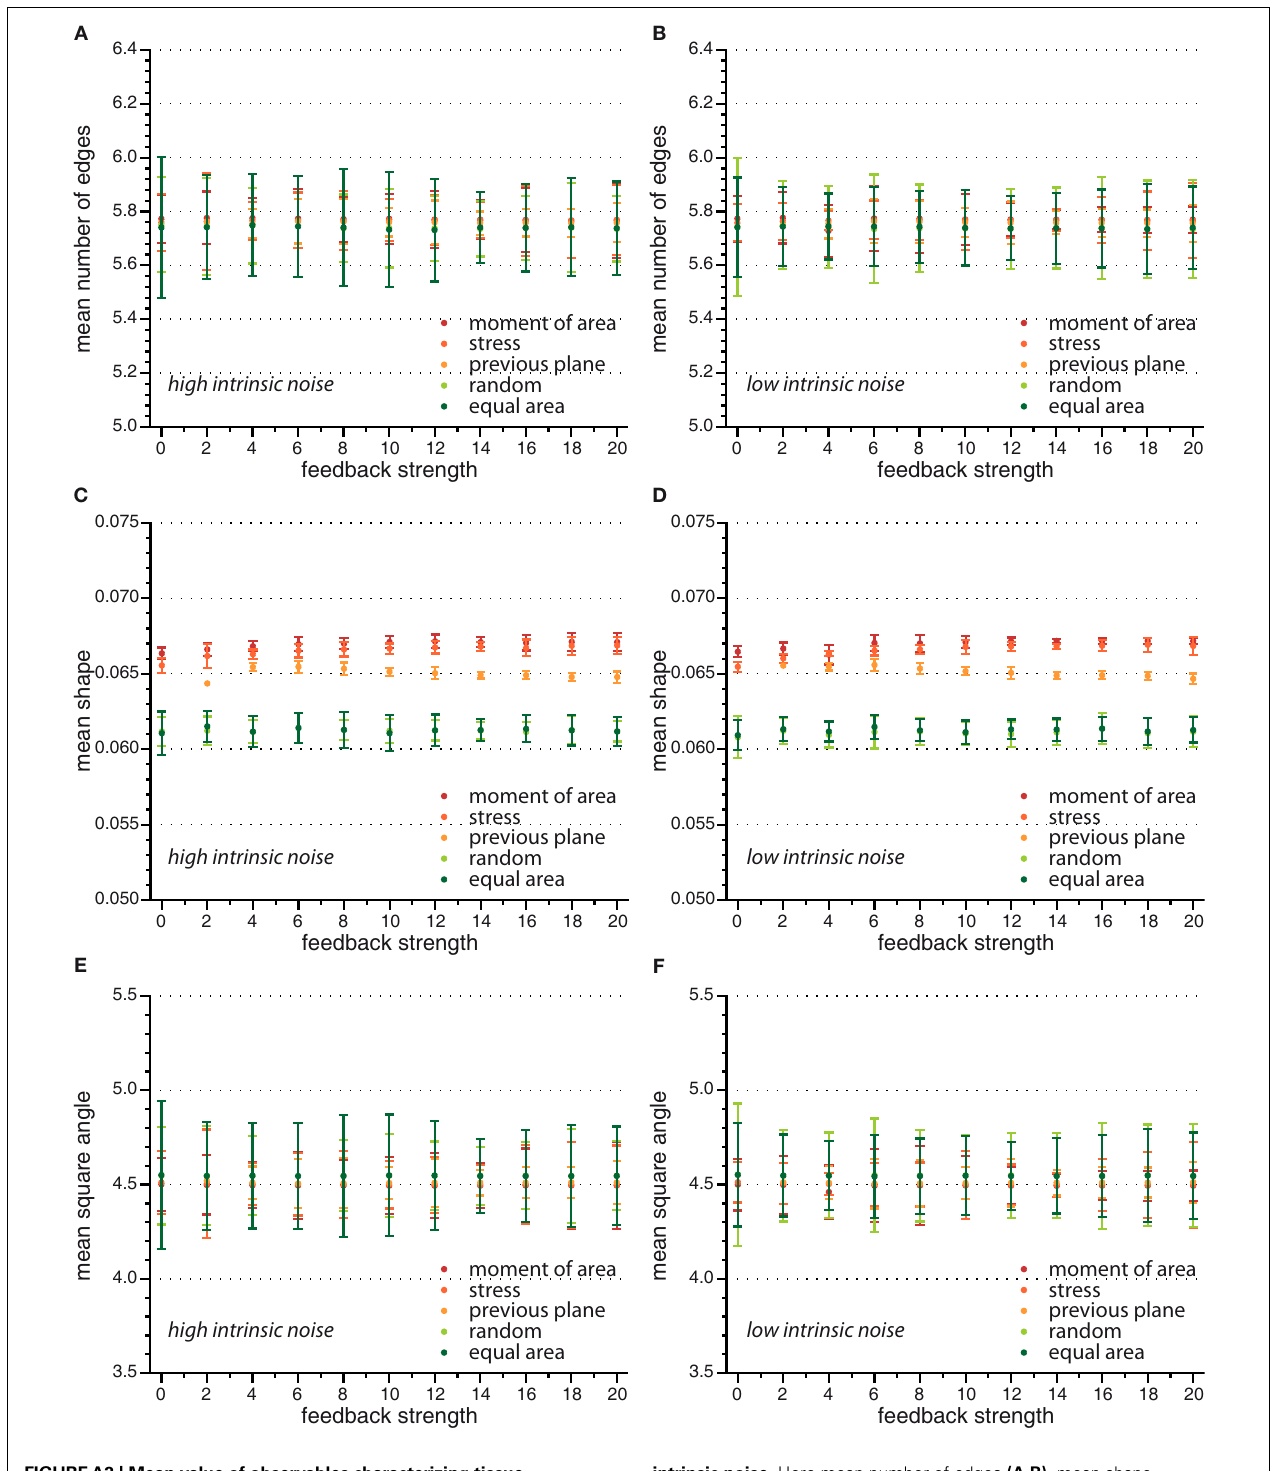
FIGUREA2 | Mean value of observables characterizing tissue geometry, topology, and stress distribution for the different cell division modes versus feedback strength for high and low